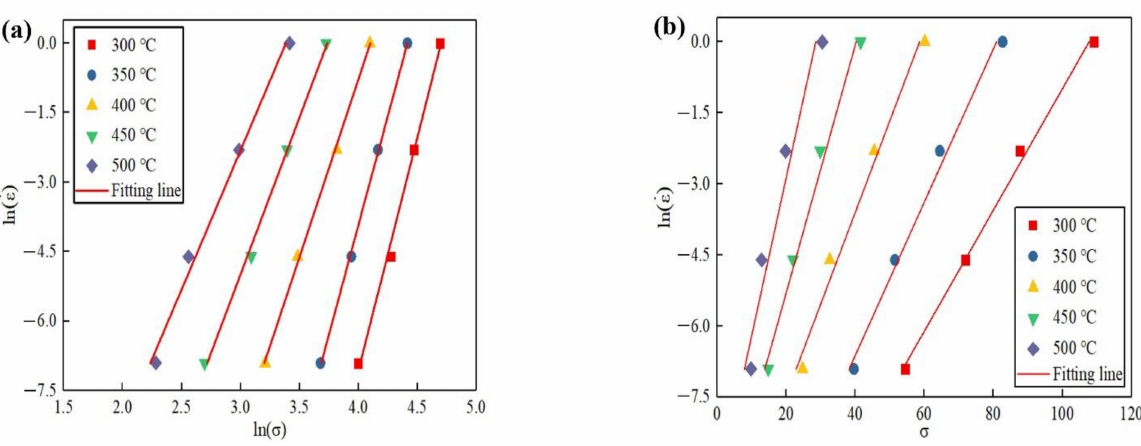
. ε with ε = 0.6: ( a ) the relation between ln σ and . ε